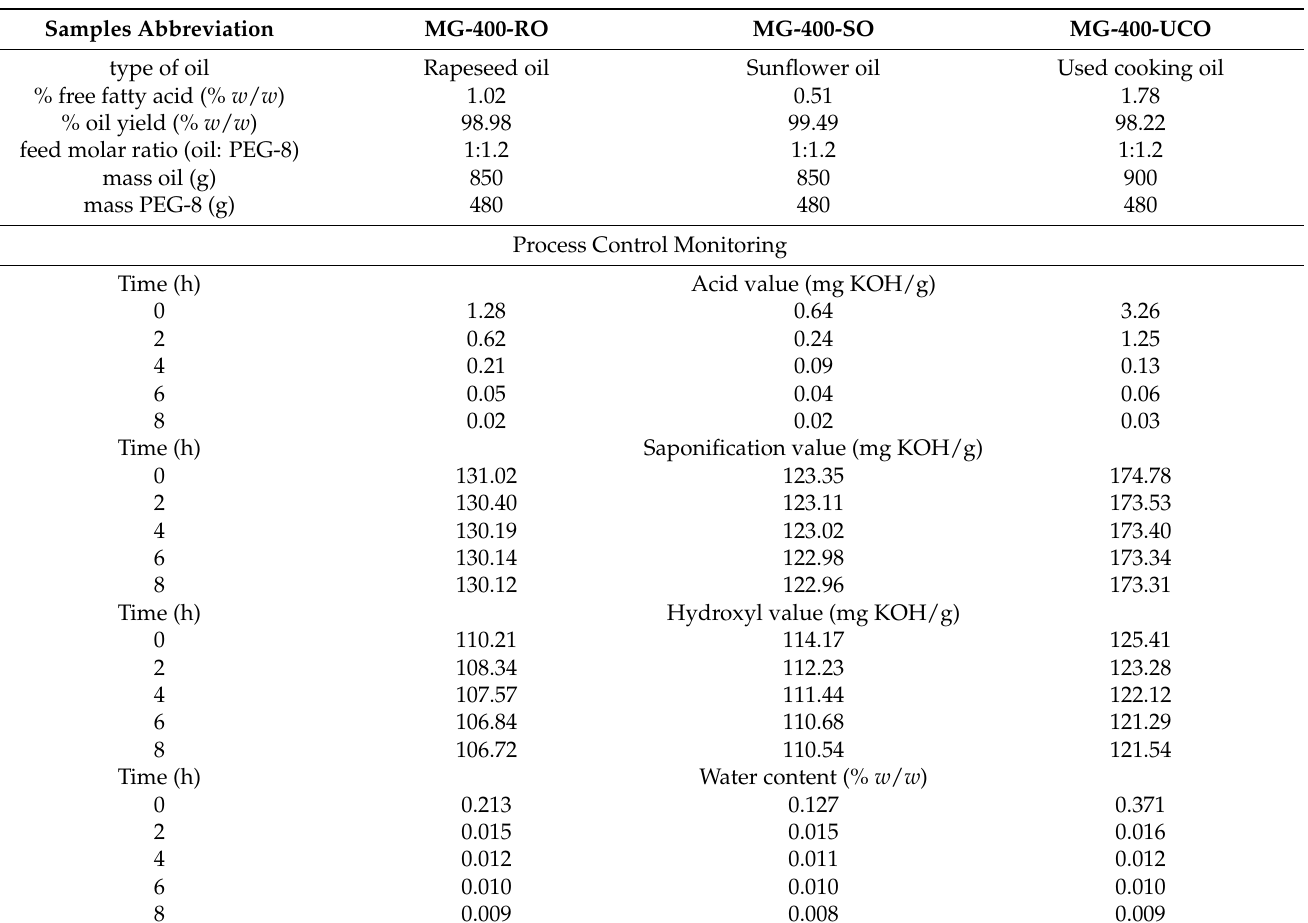
Table 1. The esterification/transesterification process monitoring (fabrication of Oil PEG-8 ester solvents). Samples